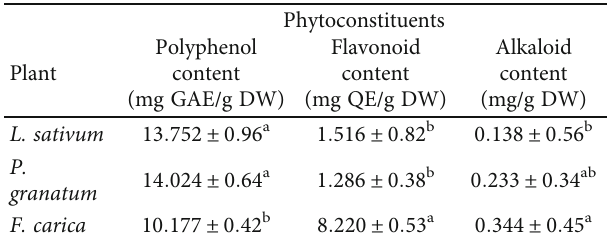
Table 1: Polyphenol, fl avonoid, and alkaloid content of Lepidium sativum , Punica granatum , and Ficus carica methanolic